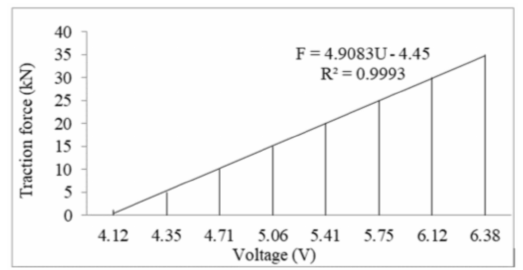
Figure 3. Dependence of traction force on